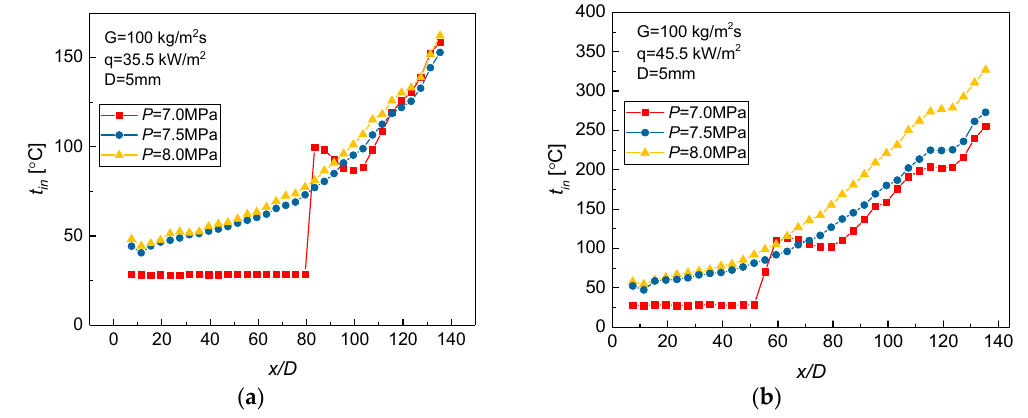
Figure 10. Variations in inner-wall temperatures with pressure. ( a ) Heat flux ( q ) = 35.5 kW/m 2 ; ( b ) q = 45.5 kW/m 2 .